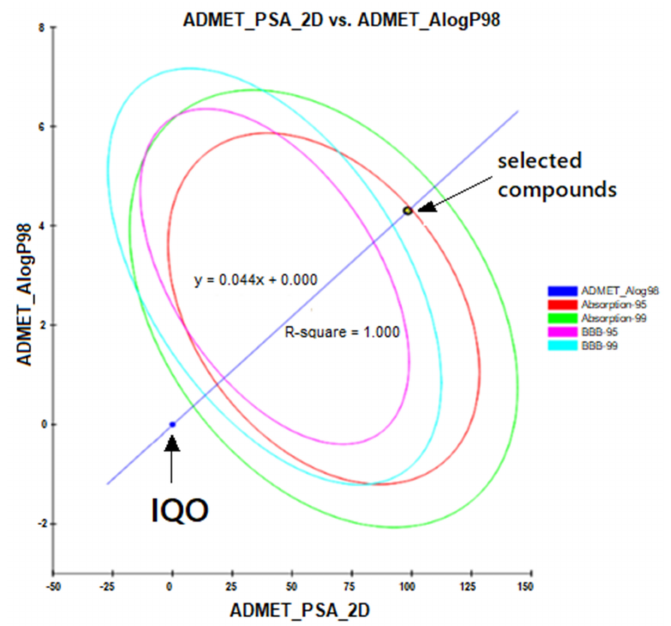
Figure 4. ADMET plot. The ADMET plot shows the relationship between the 2D polar surface area and the partition coefficient (n-octanol/water) algorithm, of the solution in which the bioavailability of the vitamin E compounds is calculated. The four ellipses define the regions where the inhibitors are expected to be well absorbed by the system and where they are expected to be located. In theory, for intestinal absorption, the inhibitors are well absorbed between 95 and 99% of the established confidence interval, if they fall within the ellipses colored in red and green, respectively. While, for absorption at the level of the blood–brain barrier, the inhibitors are well absorbed between 95 and 99% if they fall within the ellipses colored in magenta and cyan,